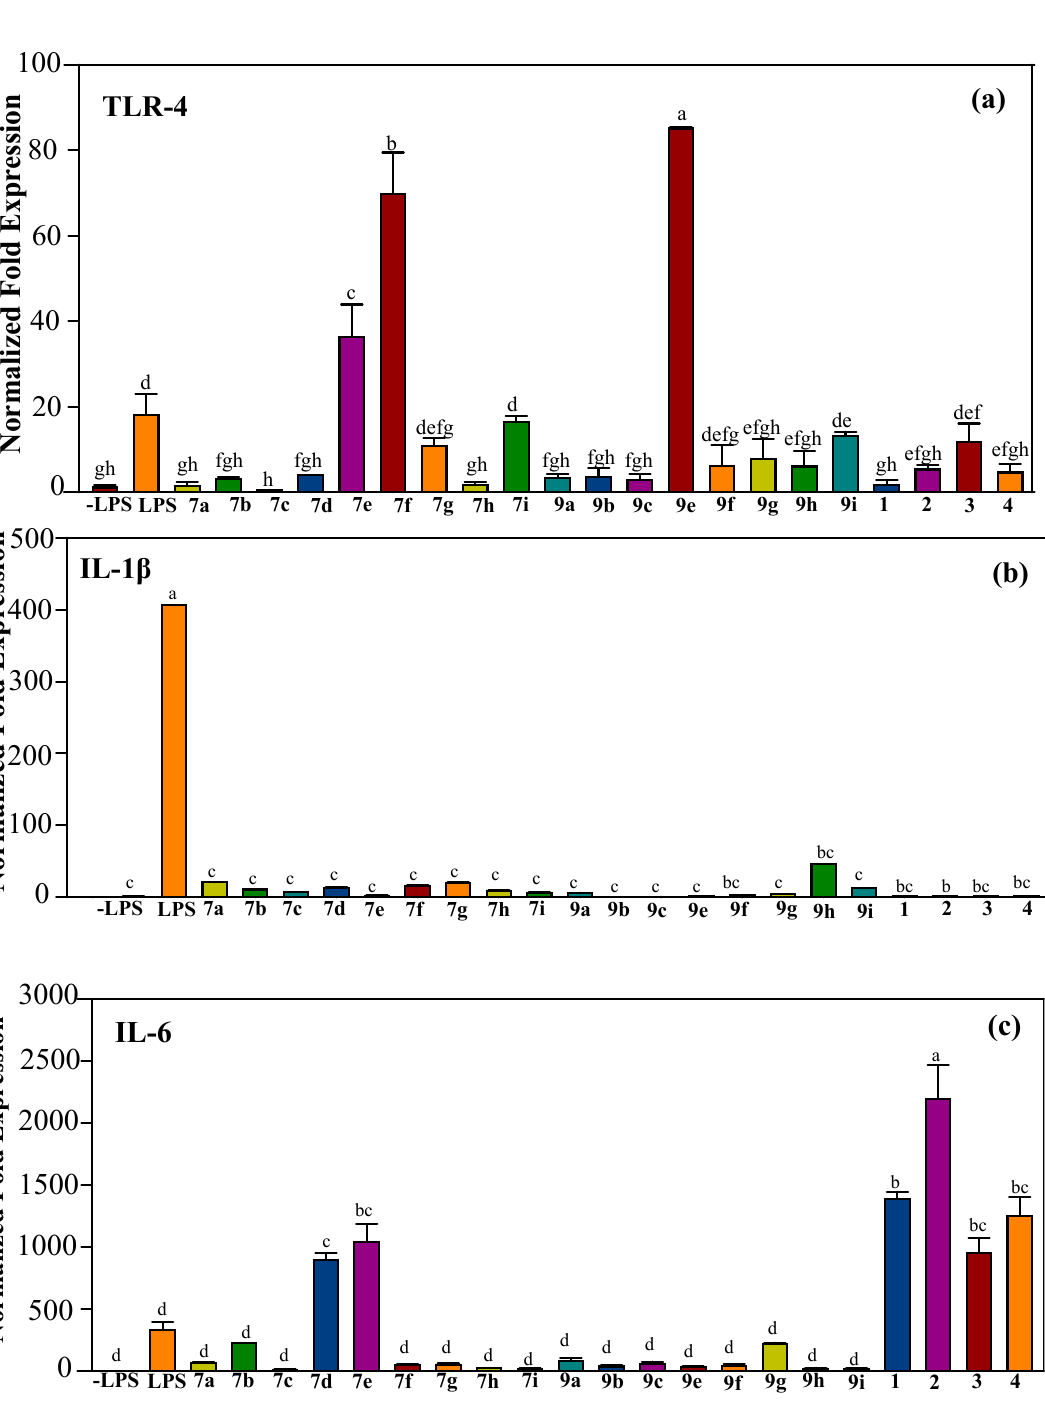
5 of 14 Figure 6. TLR4-mediated NF- κ B signaling pathway. Pre-treatment with some synthetic chalcones and azachalcones ameliorated the expression of TLR-4, IL-1 β , IL-6, TNF- α , and COX-2 induced by LPS (Figures 7 and 8). IL-1 β , IL-6, and TNF- α are pro-inflammatory cytokines secreted by macrophages to initiate and regulate the progression of inflammation [36]. IL-1 β is the master inflammatory cytokine in the IL-1 family produced at the early stages of the immune response. IL-1 β plays a crucial role in recruitment of monocytes to the inflammation site and interactions between immune cells and nerve cells [37]. Similar to IL-1 β , IL-6 is an endogenous pyrogen that promotes fever and the production of acute phase proteins from liver. IL-6 also involves in the recruitment of immune cells to inflammation site [38]. TNF- α was first described for its ability to induce necrosis of tumor cells. Binding of TNF- α to receptors TNFR1 or